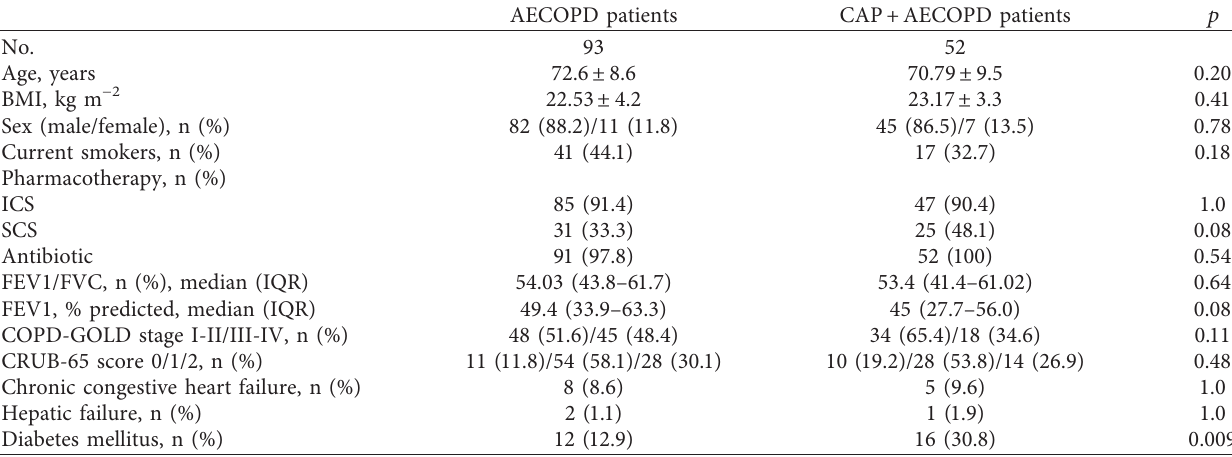
Table 1: Basic characteristics of subjects included.